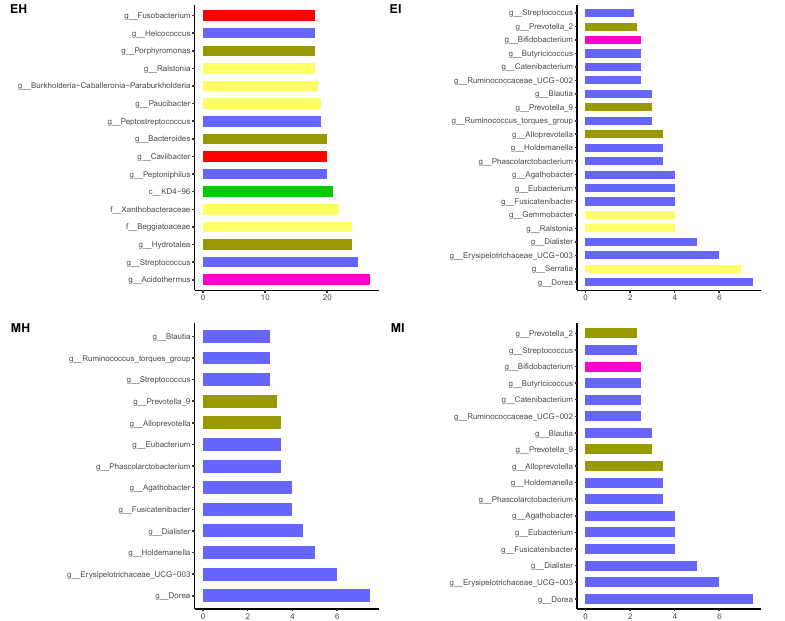
Figure 9. Ranking of important nodes in the gut microbiome network. (EH: emergence period, healthy; EI: emergence period, infested; MH: mating period, healthy; MI: mating period, infested).